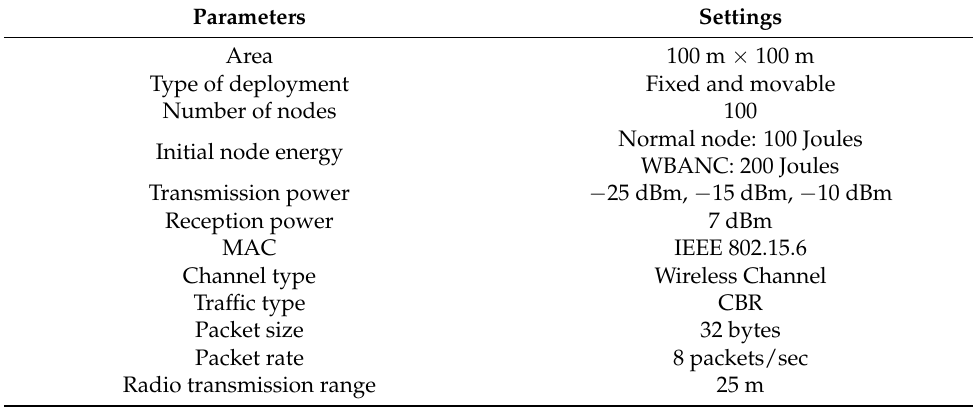
Table 2. Experimental